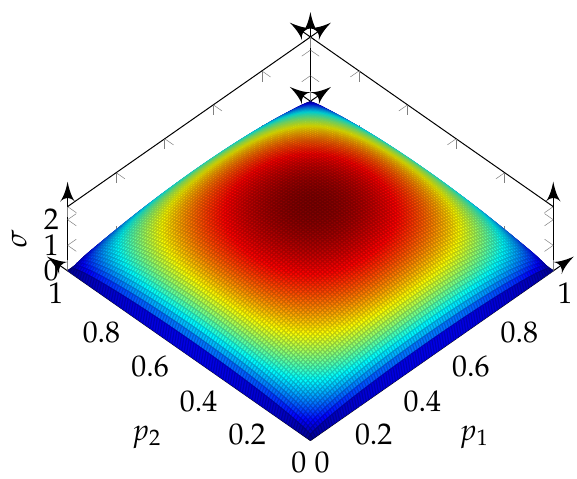
Figure 9. Standard deviation for the event of a one in the output bit-stream for the input bit-streams x 1 and x 2 , with the probability of ones p 1 2 , operated by OR or by AND. |